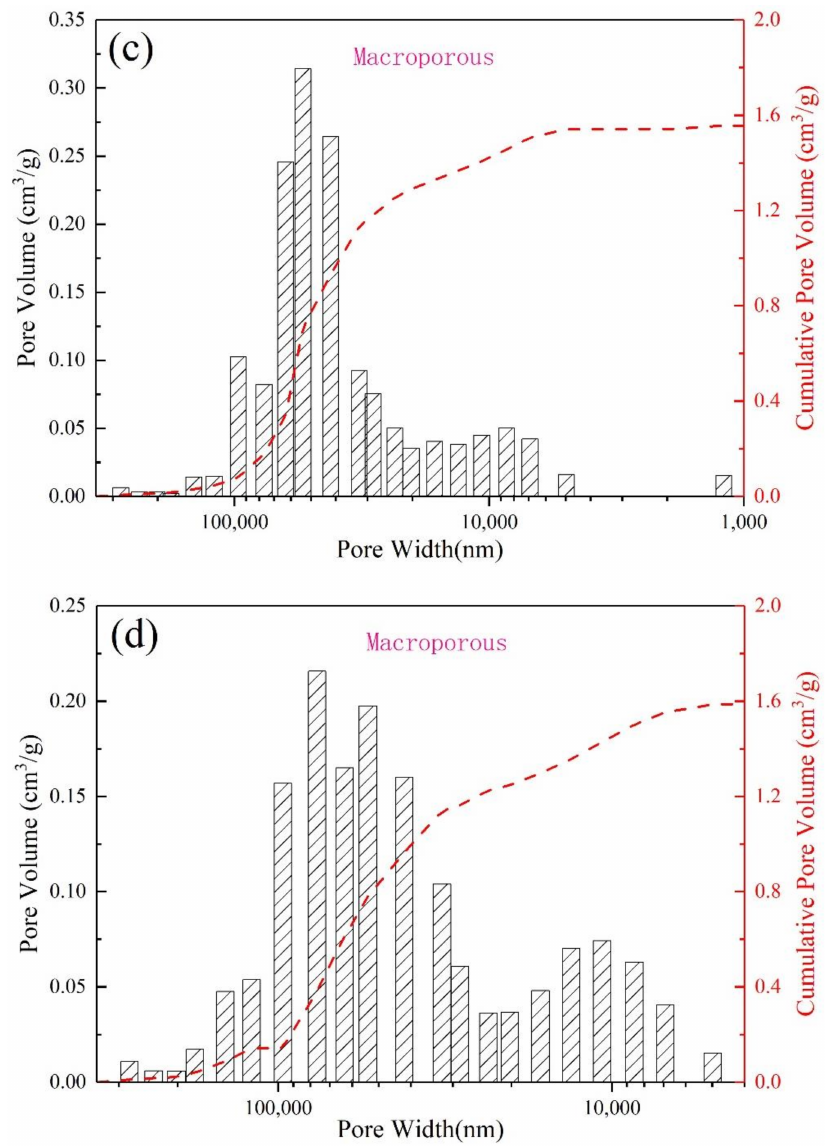
Figure 7. MIP characterization for ( a ) FAA1.0, ( b ) AF0.5-2, ( c ) AF1-1, and ( d )